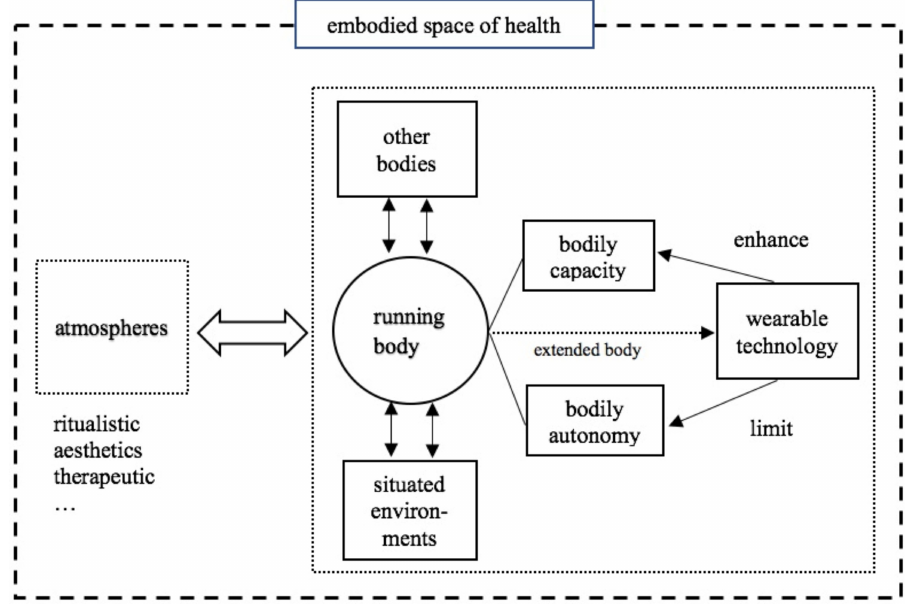
Figure 1. The model of the embodied space of health in marathon